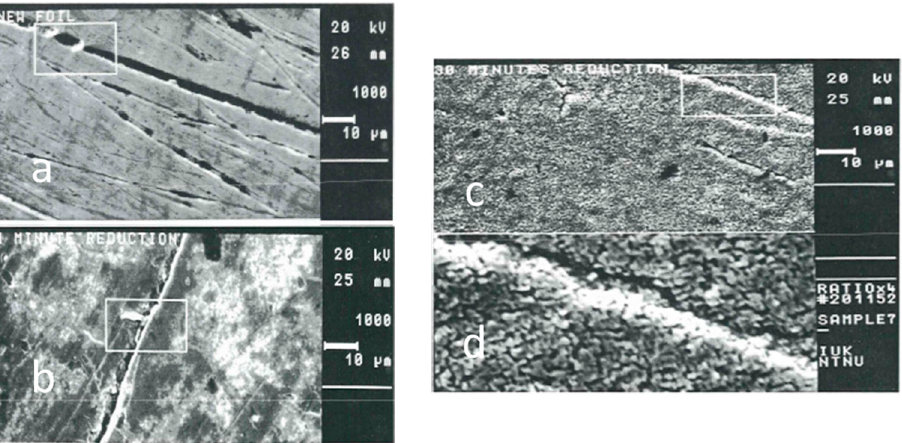
Figure 3. ( a ) SEM micrograph of an unused cobalt foil. ( b ) SEM micrograph of a cobalt foil used four times, reduced in 1 min. ( c ) SEM micrograph of a cobalt foil used 23 times, reduced in 30 min. ( d ) Micrograph enlarged four times of the marked area in ( c ).